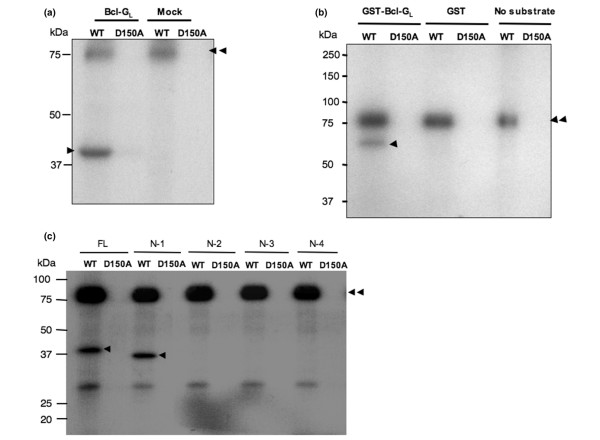
MELK phosphorylates Bcl-GL in vitro. (a) Immunoprecipitates were subjected to immune complex kinase assay with wild-type (WT)-MELK or kinase-dead (D150A)-MELK). The single arrowhead indicates phosphorylated Bcl-GL, and the double arrowhead points to an autophosphorylated MELK protein. (b) Phosphorylation of a bacterial glutathione S-transferase (GST) Bcl-GL fusion recombinant protein (GST-Bcl-GL) by His-tagged WT-MELK (WT). The single arrowhead indicates phosphorylated GST-Bcl-GL protein, and the double arrowhead indicates an autophosphorylated His-tagged MELK protein. (c) In vitro phosphorylation of various partial amino-terminal constructs of Bcl-GL (N-1, N-2, N-3 and N-4; see Figure 3e) and full-length Bcl-GL (FL) by MELK. The single arrowheads indicate phosphorylated immunoprecipitated Bcl-GL proteins, and the double arrowhead indicates an autophosphorylated MELK recombinant protein.